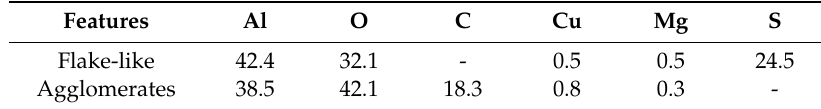
Table 5. Average chemical composition (in wt %) of the flake-like features and agglomerates on the CF-PPS by EDS